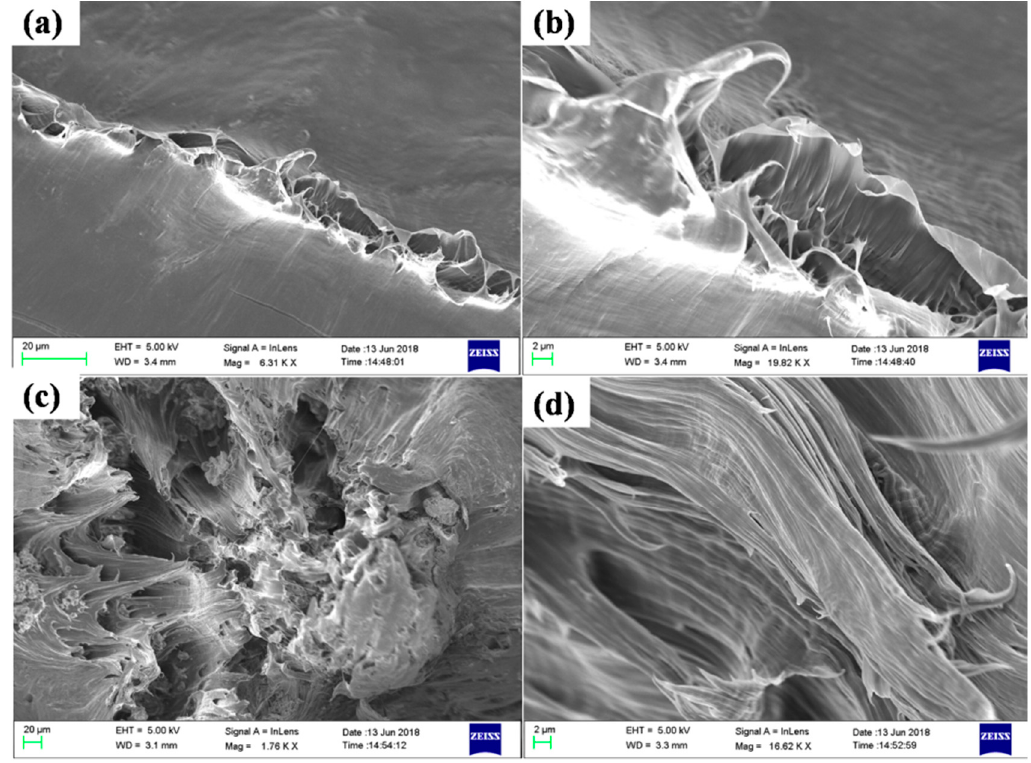
Figure 5. FE-SEM images of the tensile fractured surface of ( a , b ) neat epoxy and ( c , d ) CTAB–MoS 2 (2 wt %)/LLDPE composite.